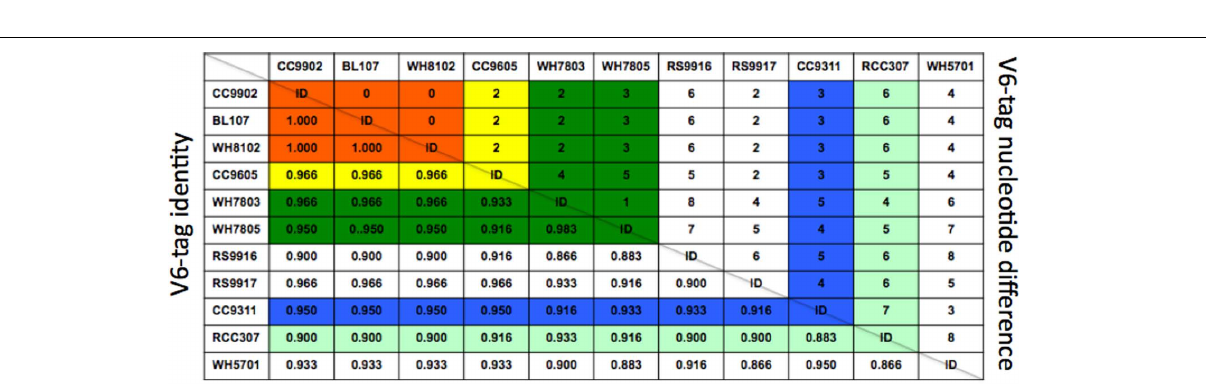
cladeV/VI (differ by a single nucleotide),clade X and the